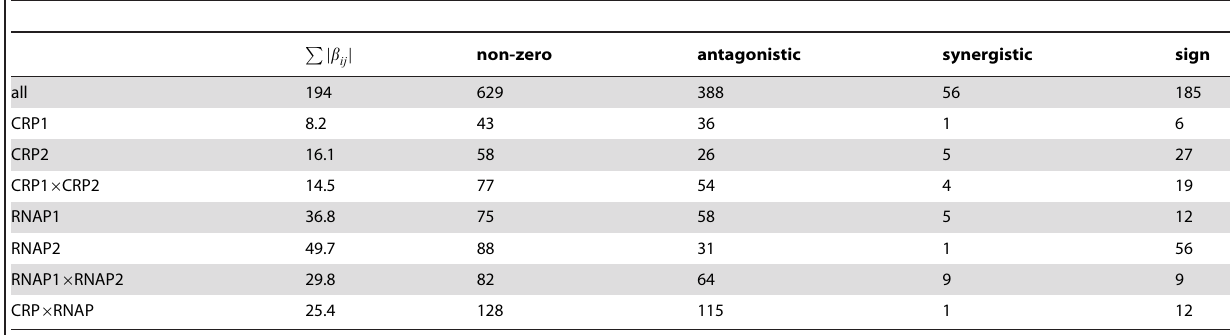
Table 2. The interaction coefficients for l ~ 0 : 021 are clustered around the subunits of the system: CRP, RNAP, and their constituent binding sites (defined by white rectangles in figure